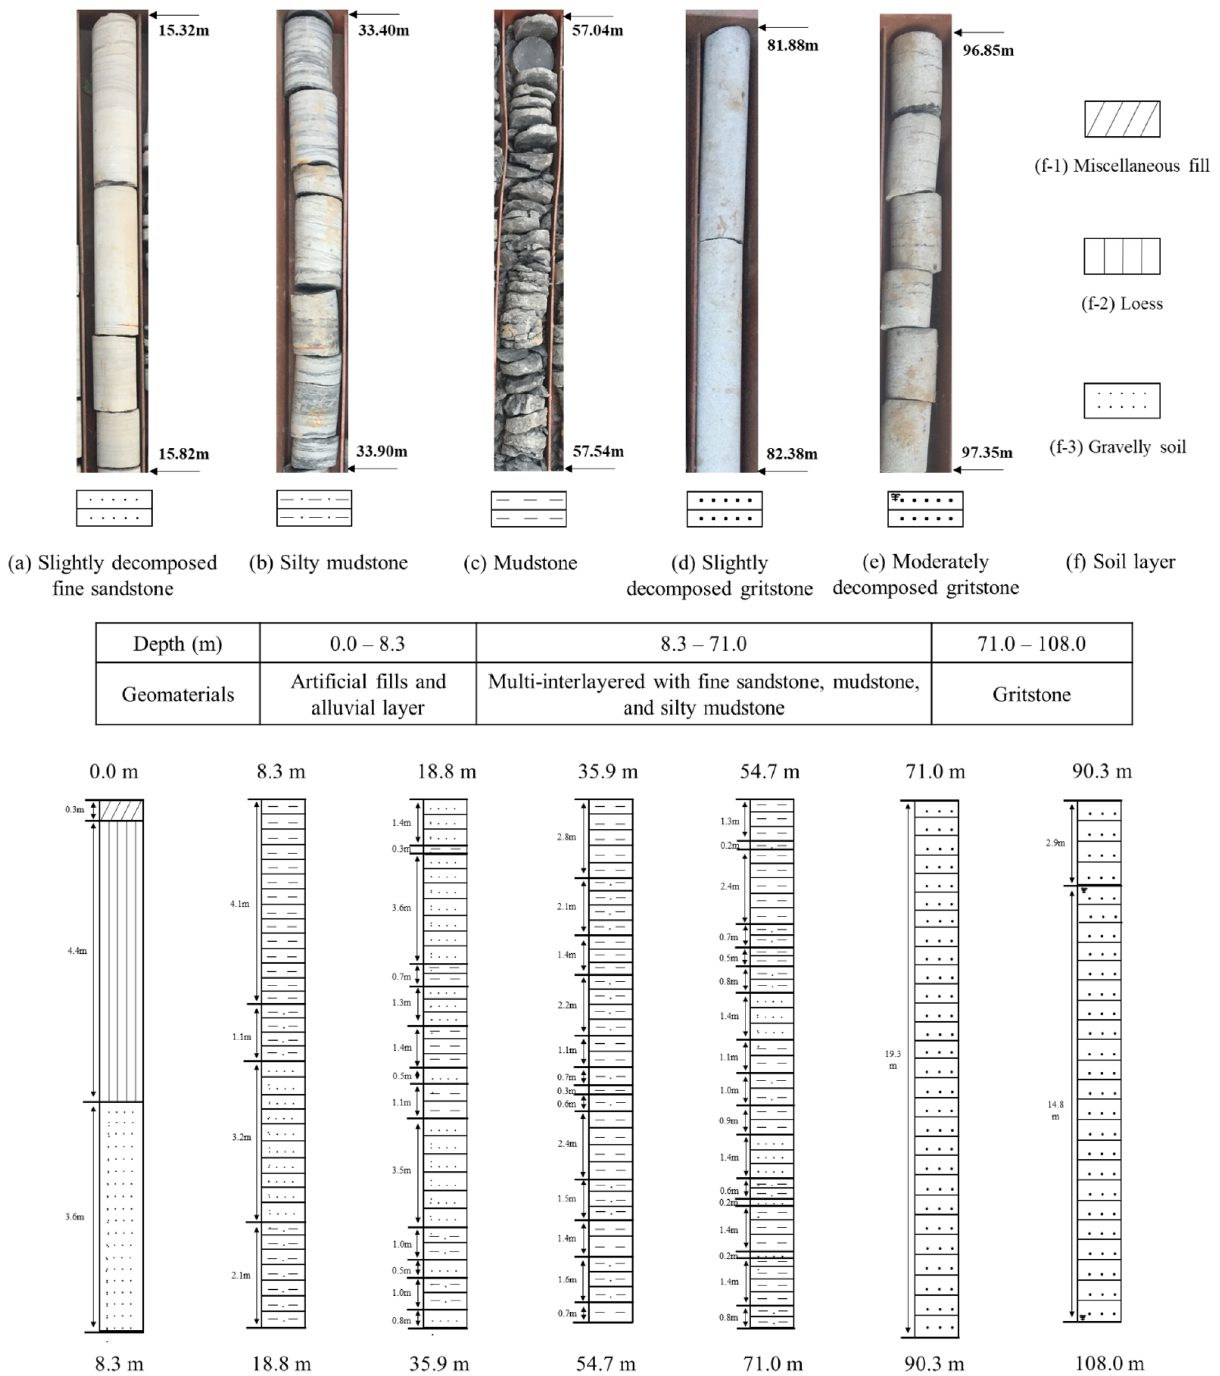
Figure 1. Eight types of strata along this 108 m drillhole with selected rock core samples and corresponding standard stratigraphic column by manual site drilling bit in hydraulic rotary drilling provides horizontal force to grind the touched geomaterial surface. The rotation sensor accuracy is one revolution per second (60 revolutions per minute). The displacement monitoring system (Fig. 2b) contains one swivel displacement transducer and the associated protection and fixture devices. The drill bit breaks the ground materials and advances into new ground materials below the bit. The system can record the drill bit displacement from the downward or upward displacement of the swivel drill chuck head along the two vertical hydraulic cylinders during the whole drilling process. The ram stroke length of the cylinders is the maximum vertical displacement distance for the drill chuck head, which is 500 mm in this case. The displacement sensor accuracy is 0.001 m.